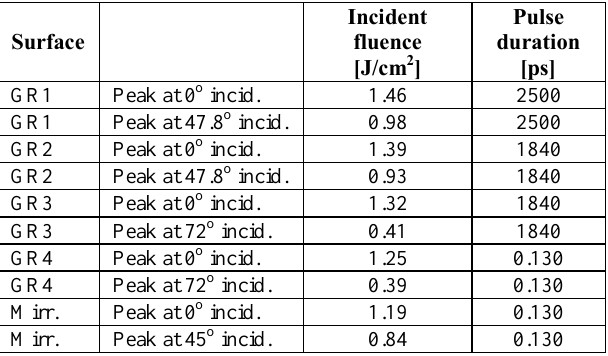
Table 2: List of fluences incident on the individual gratings of the compressor for a 10PW laser (input energy 1900